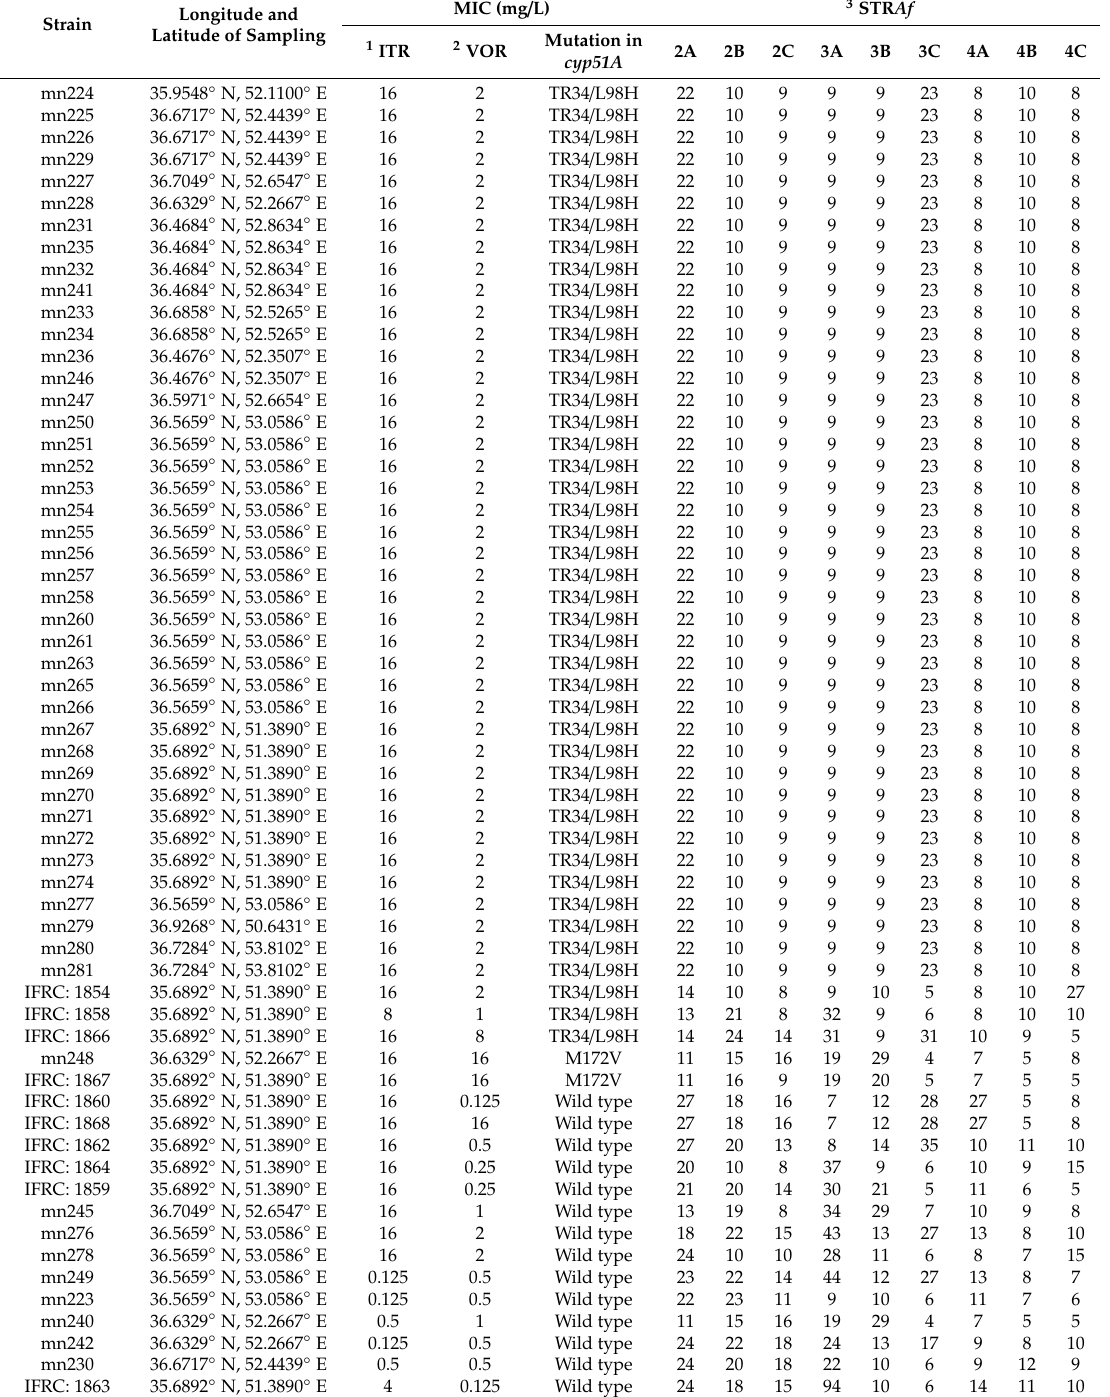
Table 1. Description of all A. fumigatus isolates from